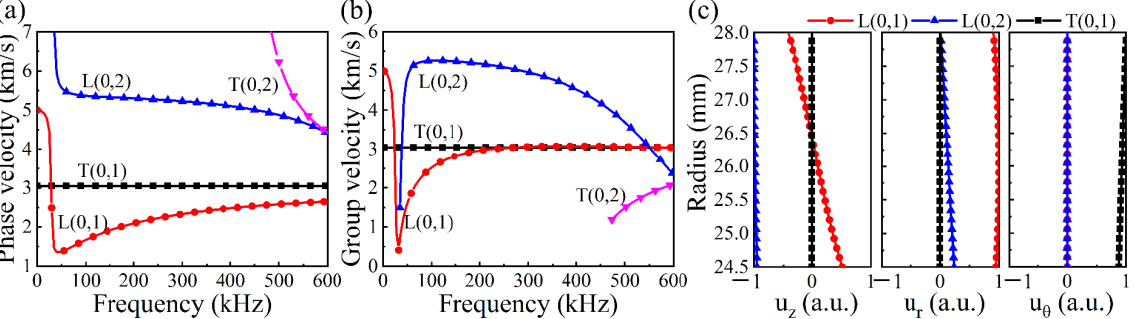
Figure 1. Dispersion curves of axisymmetric UGWs: ( a ) phase velocity, ( b ) group velocity and ( c ) normalized displacement distribution.